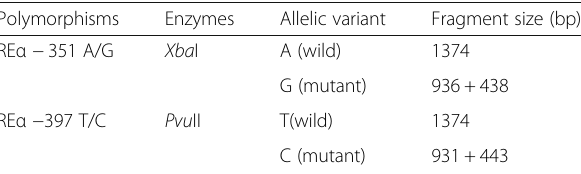
Table 1 Polymorphisms, restriction enzymes, allelic variants, andsize of DNA fragment generated by PCR-RFLP Polymorphisms